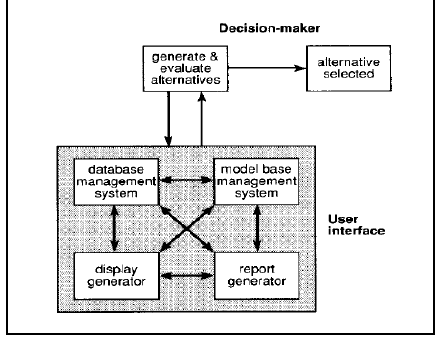
Figure 1 - Proposed architecture for SDSS (After Armstrong, Densham and Rushton,